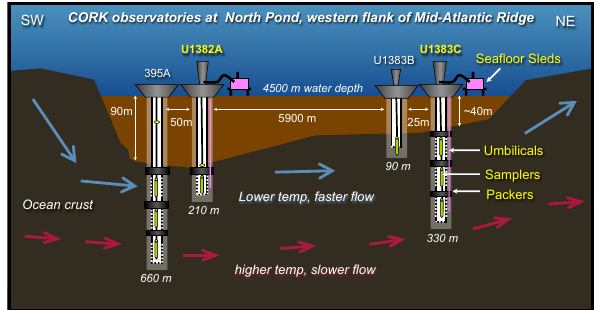
Figure 3. Simplified sketch of the geological and hydrological framework and the observatory layout at North Pond. Two obser- vatories (U1382A ad U1383C; large wellhead) are fully operational and sampling / experimentation using seafloor sleds (Cowen et al., 2012) and incubation chambers (FLOCs; Orcutt et al., 2011). In Hole U1383B, a CORK-lite (small wellhead) was installed using a remotely operated vehicle (Wheat et al., 2012). Flow lines of for- mation water are highly schematic and adapted from Langseth et al.